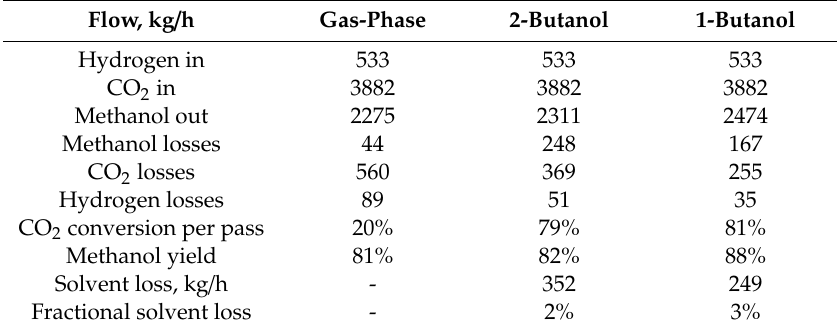
Table 5. Mass balance of the alternative methanol synthesis processes. Methanol yield is the ratio of the mass flow of methanol product to the mass flow corresponding to 100% yield based on the stoichiometric CO 2 and hydrogen inlets. Fractional solvent loss is calculated as the ratio of solvent flow removed from the process to the solvent flow (make-up + recycle) fed to the